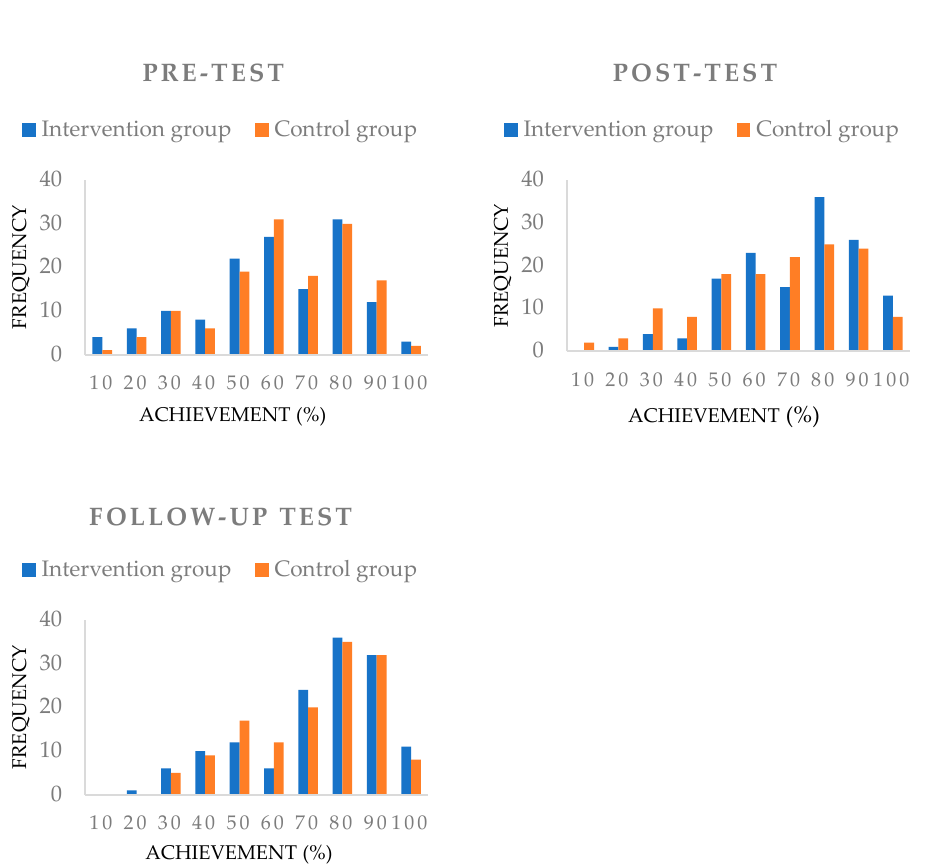
Figure 2. Frequency distribution of intervention and control group performance at three times: (1) pretest: before intervention; (2) post-test: after intervention; and (3) follow-up test: three months after intervention.